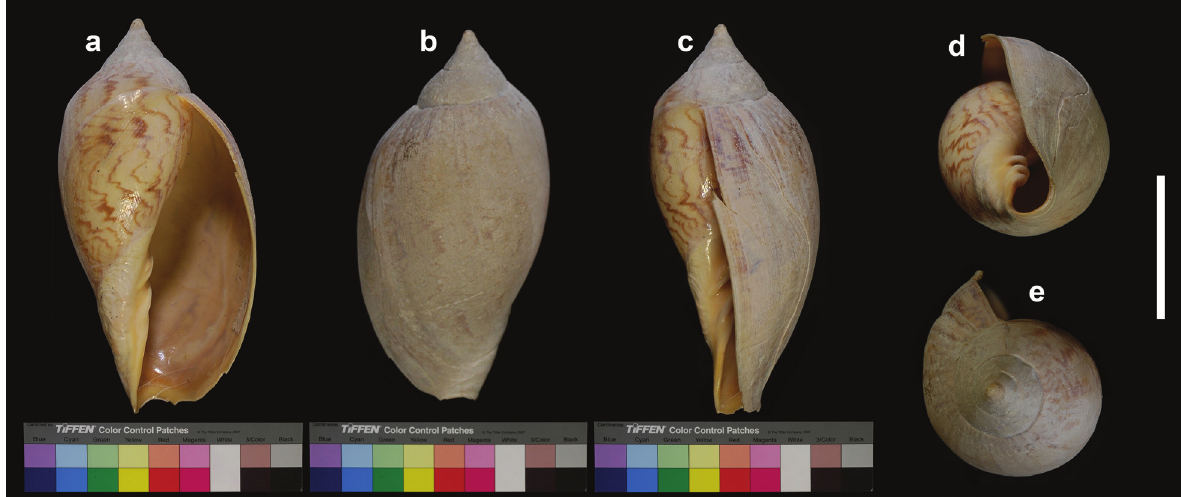
Figure 42. Holotype of Voluta magellanica curta . a Apertural view b Dorsal view c Lateral view d Umbilical view e Apical view. Scale bar: 5 cm.